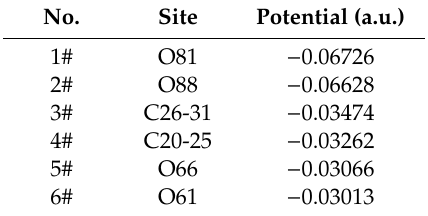
Figure 7. Front view (left) and side view (right) of electronic static potential (ESP). Table 2. Negative potential distribution on the surface of coal molecules.